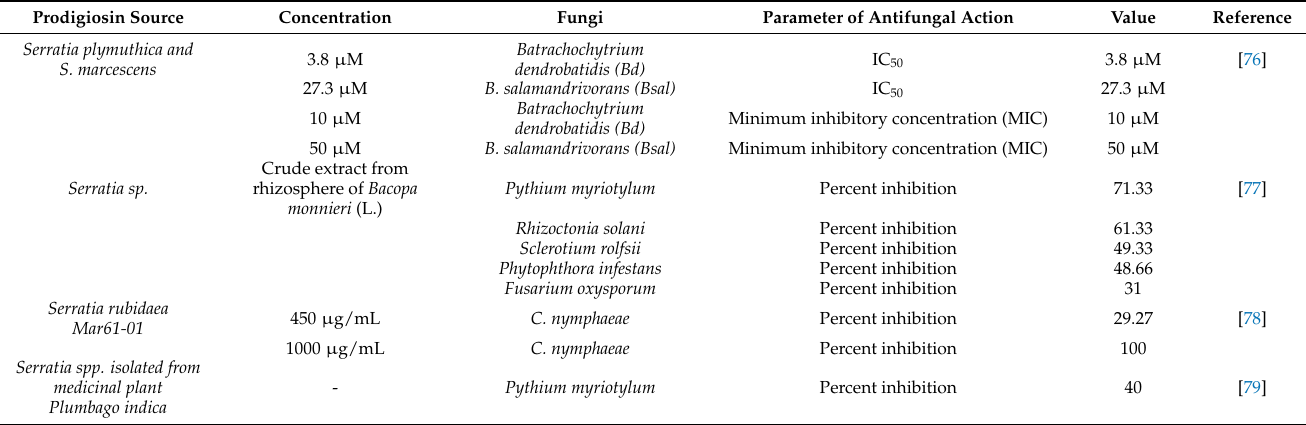
Table 3 contains different recent studies that report prodigiosin’s antimycotic effect. Table 3. Antifungal activity of